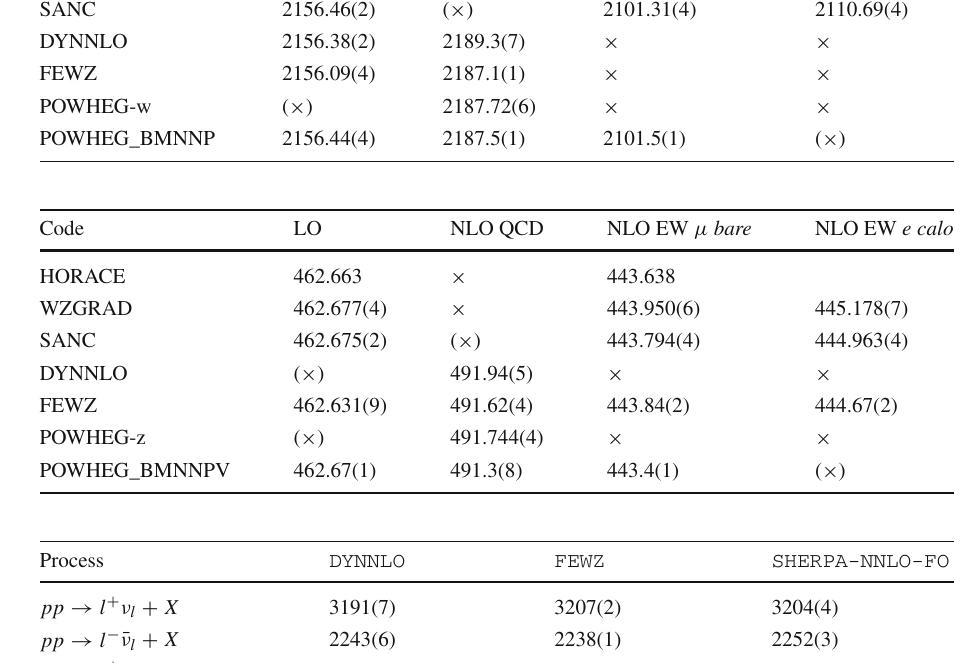
Table 10 pp → W − → l − ¯ ν l total cross sections (in pb) at LO, NLO EW and NLO QCD at the 8 TeV LHC with ATLAS/CMS cuts in the benchmark setup